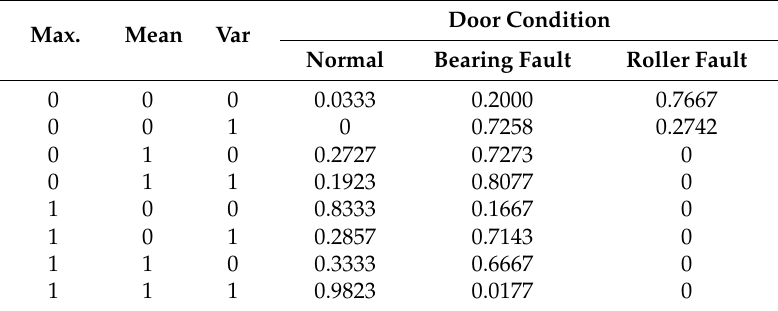
Table 4. Conditional probability table during the close